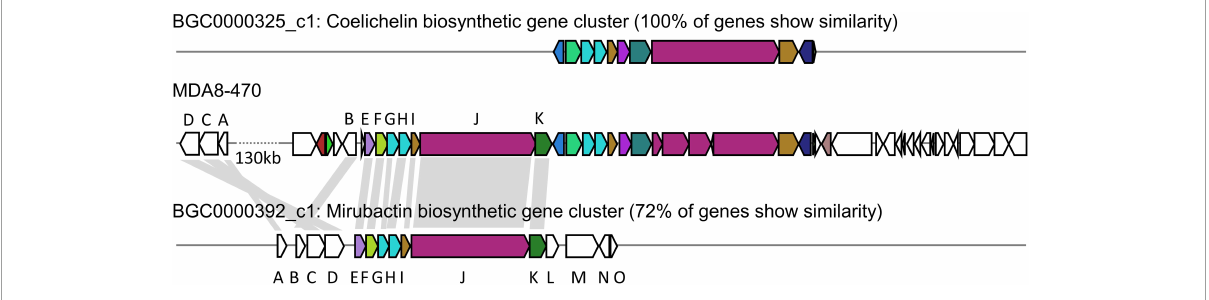
FIGURE2 Comparative genomic analysis between Streptomyces drozdowiczii MDA8-470, Streptomyces coelicolor A3 (2) and Actinosynnema mirum DSM 43827 in regards to the genetic locus of coelichelin and mirubactin. (Top) coelichelin biosynthetic gene cluster from Streptomyces coelicolor A3 (2). (Middle) Genetic locus of the mirubactin and coelichelin gene cluster in Streptomyces drozdowiczii MDA8-470. (Bottom) mirubactin gene cluster from Actinosynnema mirum DSM 43827. Homology indicated by gray blocks based on BlastP